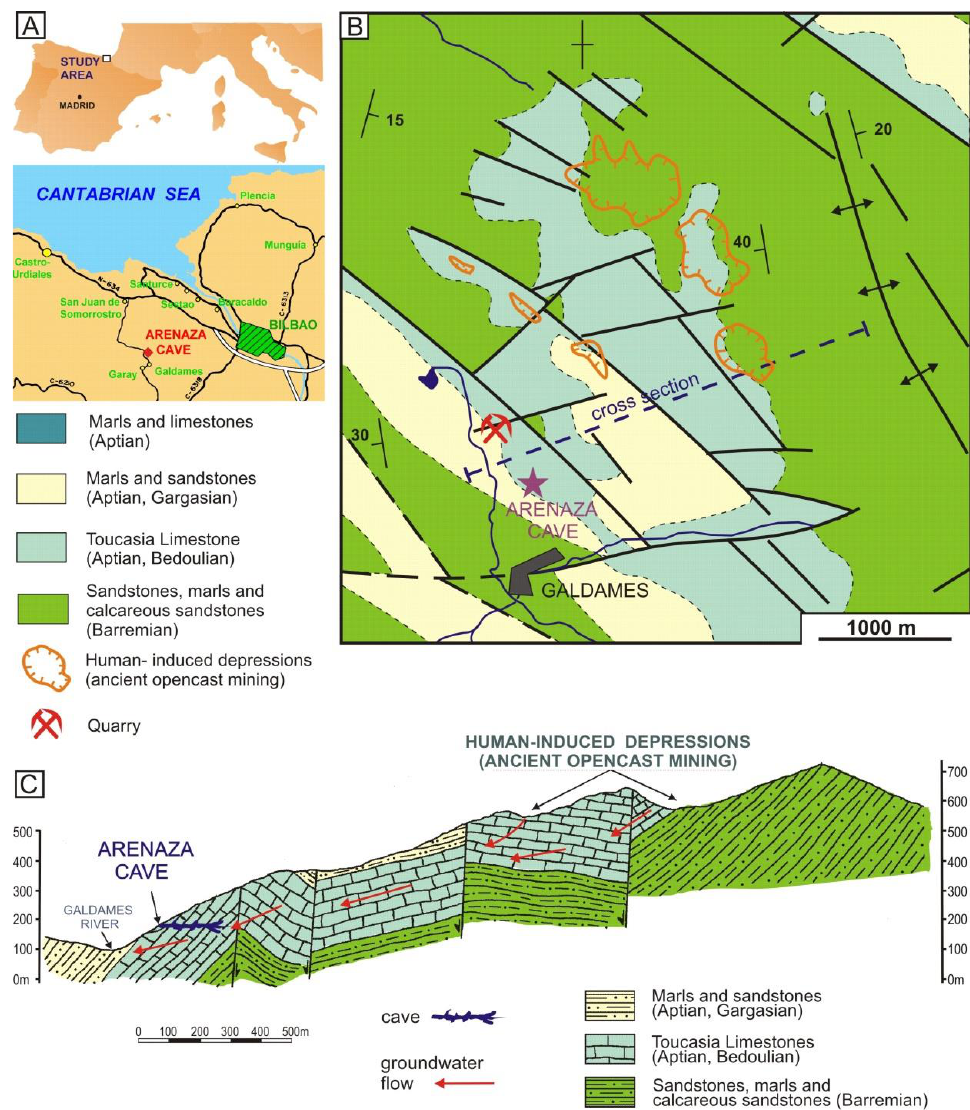
Figure 1. Geographic and geological context of the study area. ( A ) Geographical location of Arenaza cave. ( B ) Geological map of the study area. ( C ) Geological cross section.